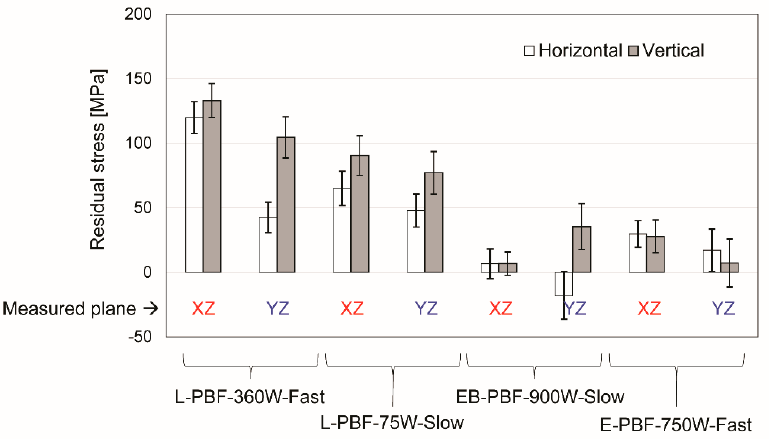
Figure 11. Averaged residual stresses over all Z positions and scan strategies for four types of process conditions.